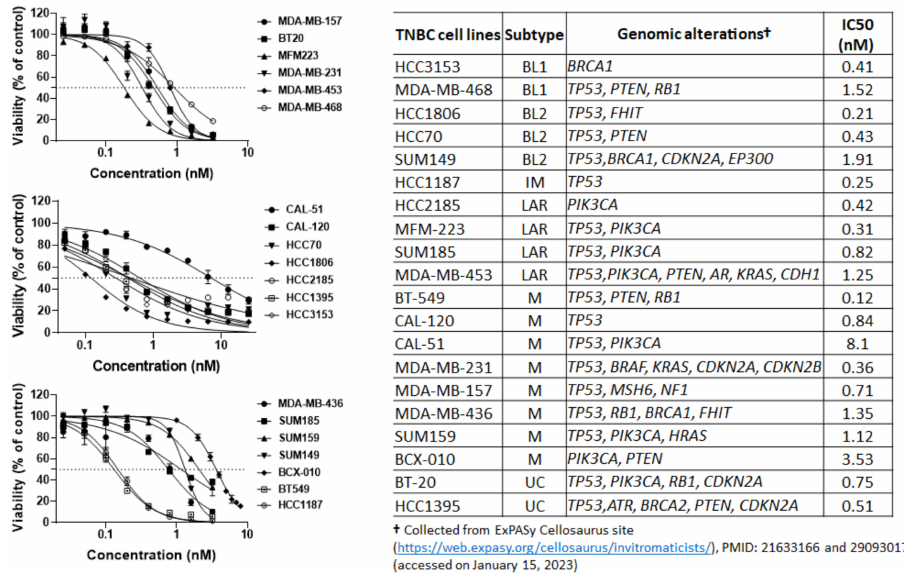
Figure 1. Anti-proliferation activity of eribulin against TNBC and IBC cells. Cells were seeded in 96-well plates and treated the next day with eribulin for 5 days. On day 5 following treatments, the cells were fixed with 5% trichloroacetic acid and then stained with 0.025% sulforhodamine B solution. The stained cells were dissolved in 10 mM Tris buffer. The optical density at 585 nm was measured using a Victor X3 plate reader. The data are representative of three independent experiments with three replications for each experiment. Cell viability is presented as a percentage of non-treated control cells. Data are presented as mean ± standard deviation. BL1, basal-like 1; BL2, basal-like 2; IM, immunomodulatory; LAR, luminal androgen receptor; M, mesenchymal; UC,